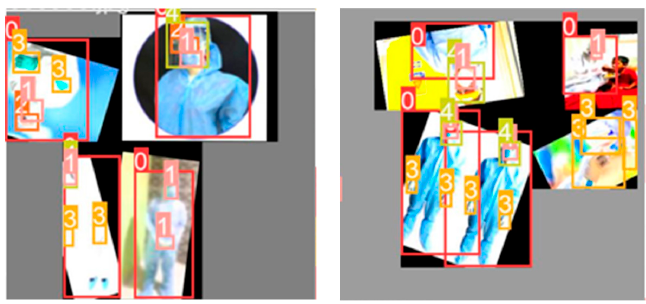
Figure 8. Mosaic data enhancement method.